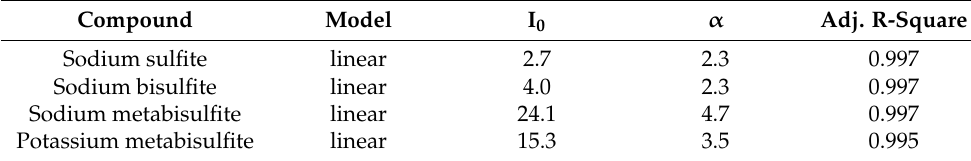
Table 3. Parameters of fitting of Dose–Response Curve for each compound